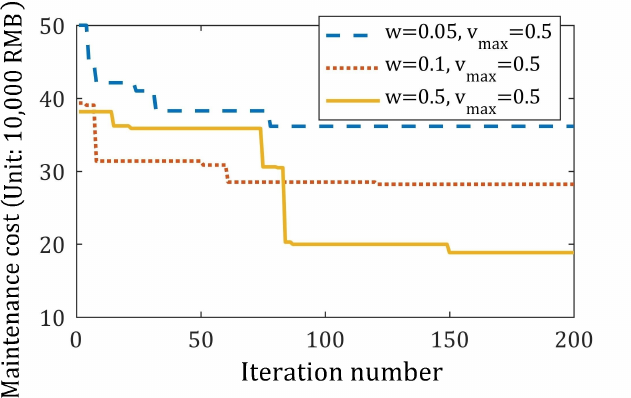
Figure 10. Iterative curves of the optimization objective under different values of w when N p = 20.